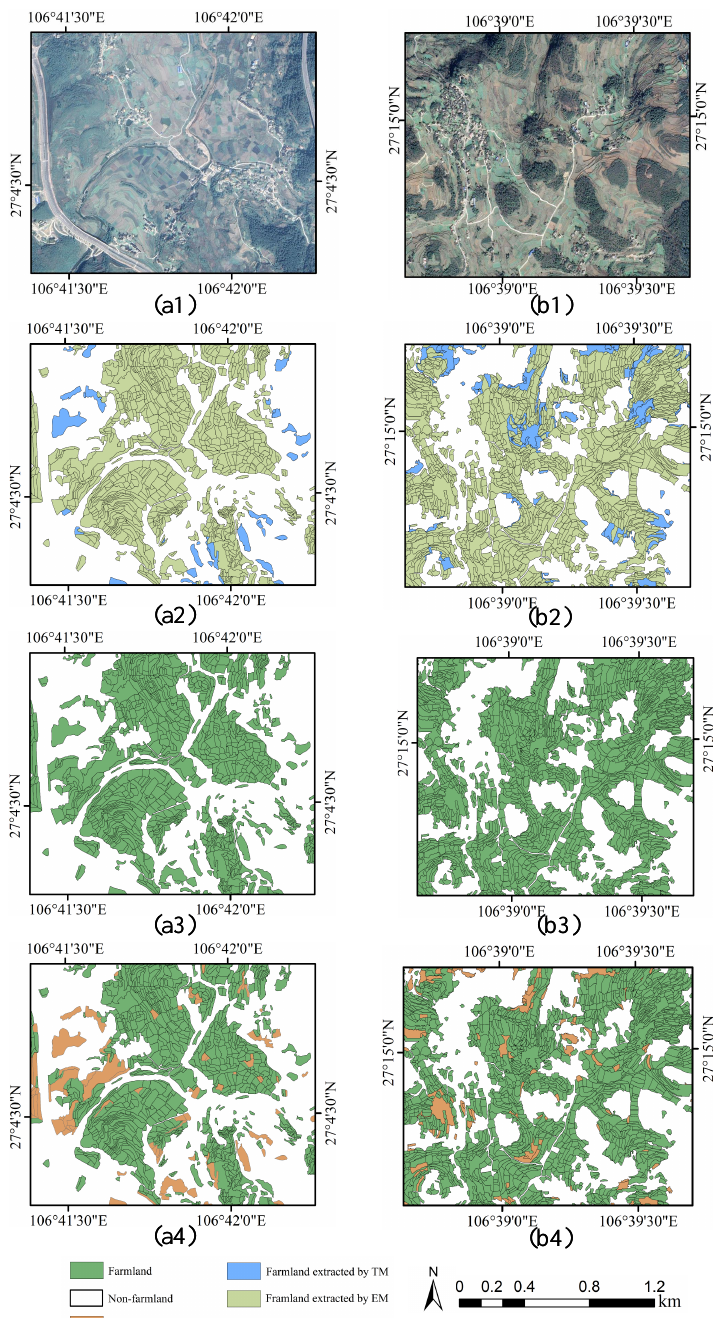
Figure 6. Detailed process of the proposed method. ( a1 , b1 ) are the sub-regions of the study area; ( a2 , b2 ) show farmland parcels extracted using different models (Stage 1); ( a3 , b3 ) are the results obtained by the hierarchical scheme using VHR images (Stage 2); ( a4 , b4 ) demonstrate the ability to identify non-farmland parcels using SAR temporal features (Stage